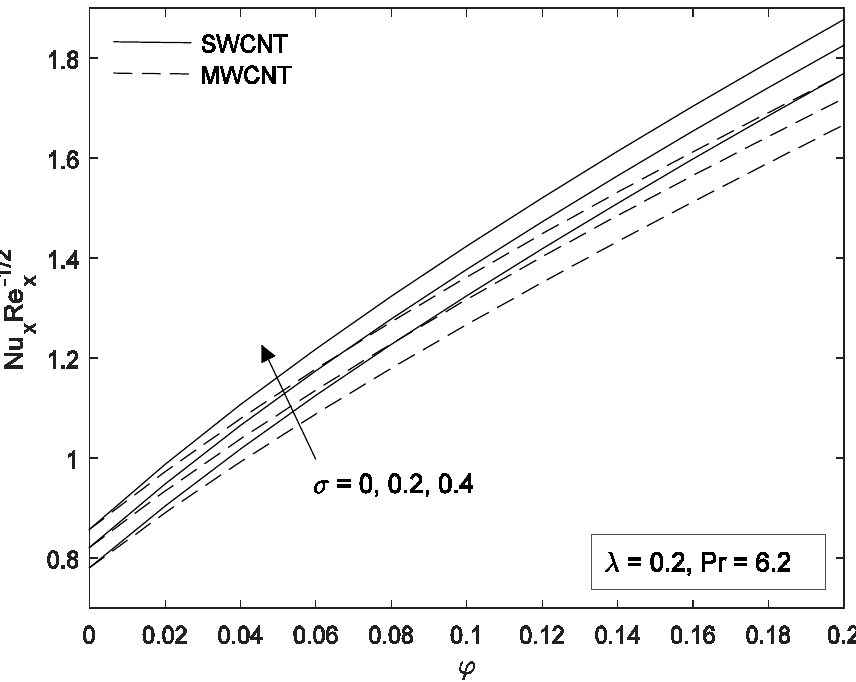
Figure 12. Effect of σ on Nusselt number for water-based fluid.